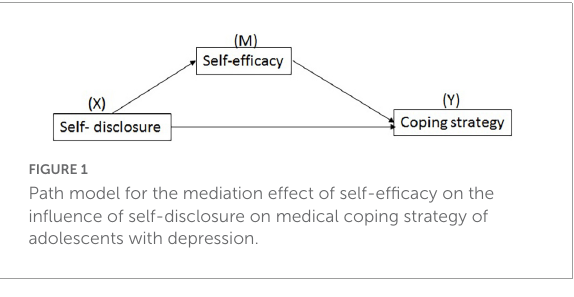
TABLE 1 The demographic and psychotypical characteristics of adolescents with depression on admission ( n = 585).